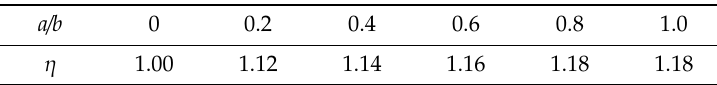
Table 2. Relationship of η and a /